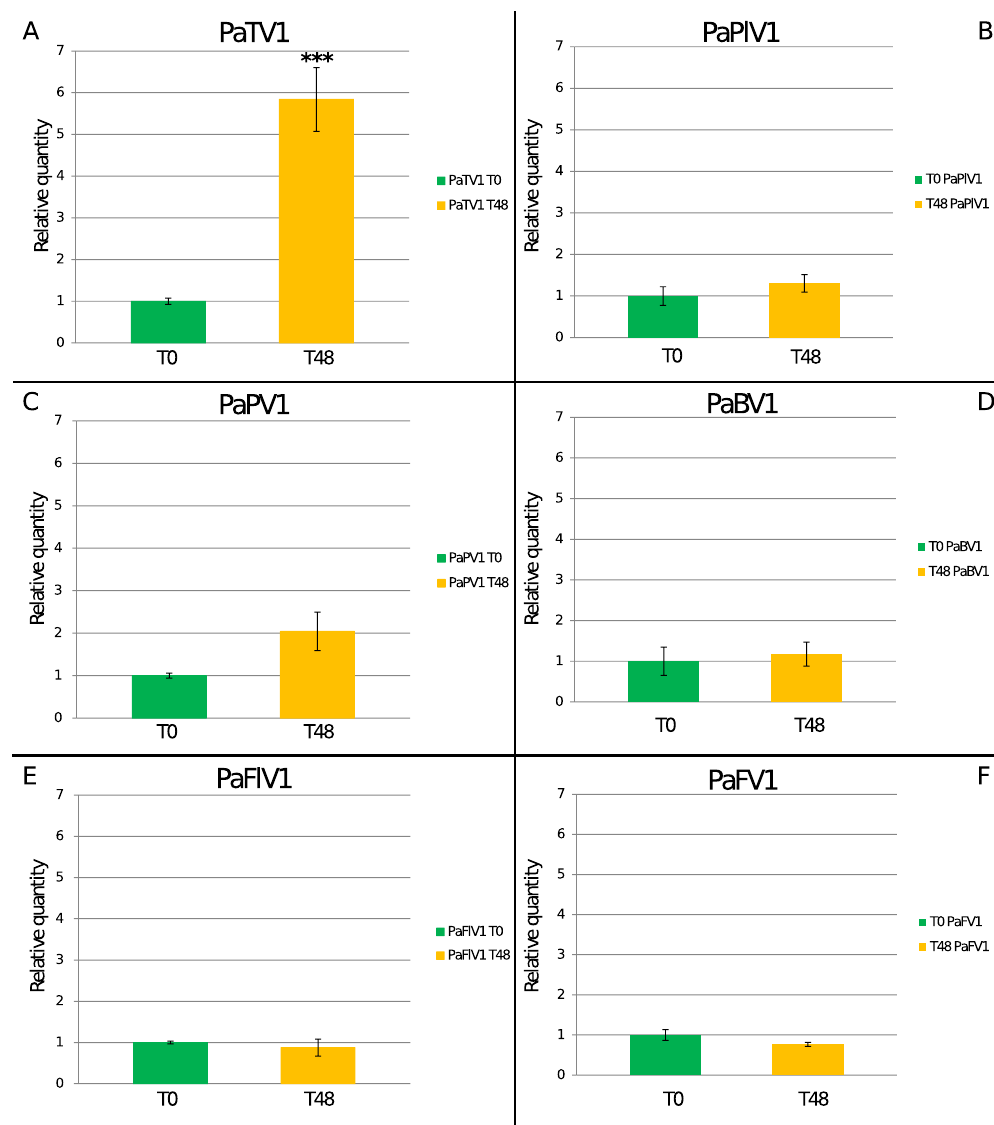
Figure 1. Absolute quantification of viral RNA in Nicotiana benthamiana protoplasts at T0 and T48 time points. Quantitative Reverse transcriptase PCR (qRT-PCR) data were used. We present the data as a fold change of viral RNA at T48 compared to T0 to which we arbitrarily assigned the value 1. In panel A absolute quantification of the Totivirus Penicillium aurantiogriseum totivirus 1 (PaTV1): quantification shows ca. 5 times more RNA at T48 (yellow bar) than T0 (green bar). In panels B, C, D, F and E quantification of the absolute virus RNAs shows no statistically significant difference over time. * P < 0.05 ** P < 0.01 and *** P <